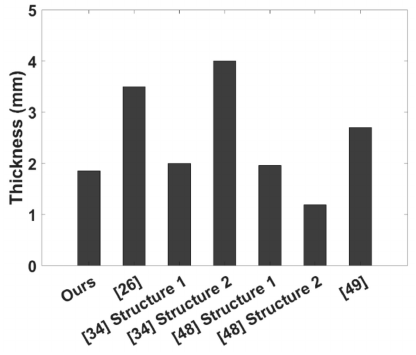
Figure 8. The thickness of the fabricated sensors in comparison to other studies.